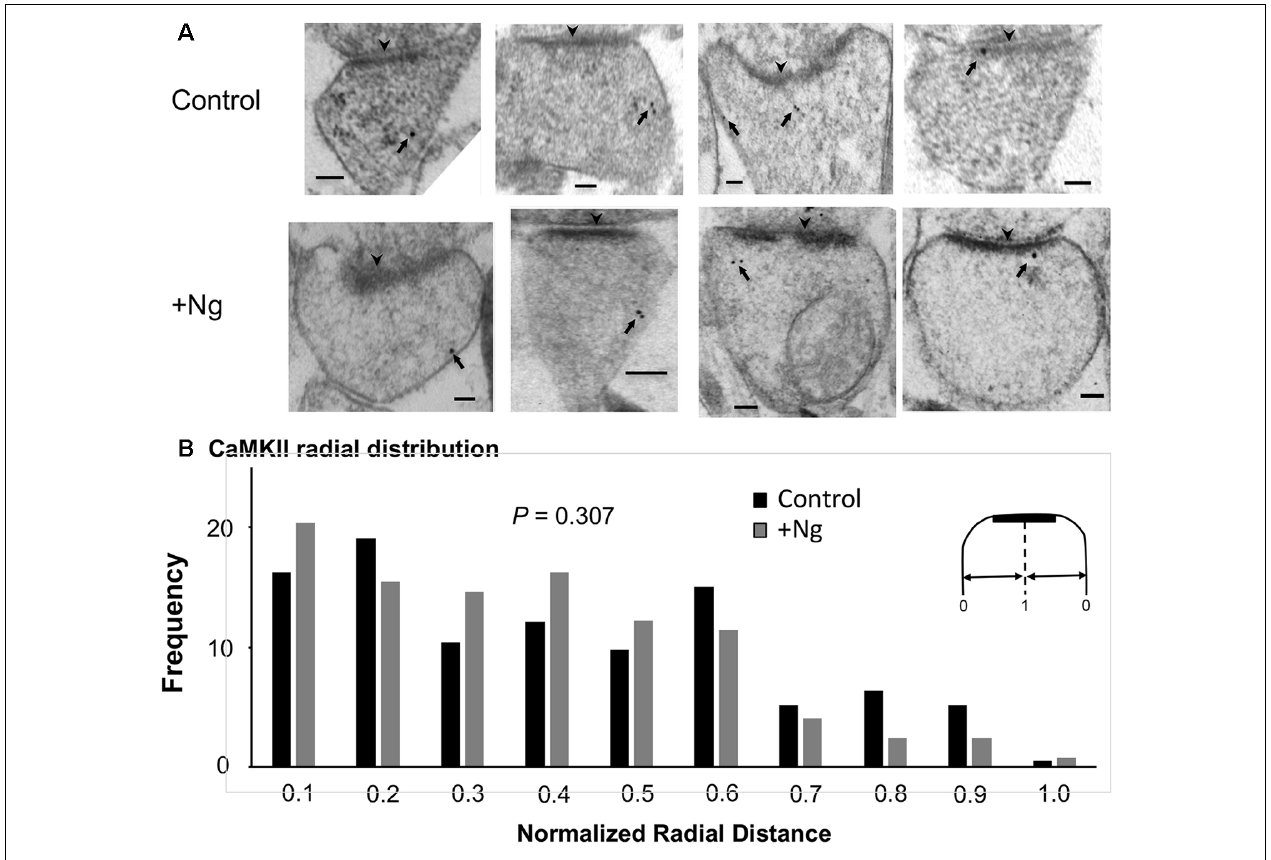
FIGURE 3 | Ng does not change the ultrastructural localization of calmodulin (CaM)-dependent protein Kinase II (CaMKII). (A) Representative micrographs of immunogold-EM for endogenous CaMKII in dendritic spines of the CA1 area for control and Ng-overexpressing neurons. The black arrowheads point to the postsynaptic density (PSD). Arrows indicate anti-CaMKII immunogold particles. Scale bar, 100 nm. (B) Frequency histogram in control ( n = 192) and Ng-overexpressing ( n = 131) neurons. The distance of each gold particle was normalized (x-axis) to the corresponding radius of the spine measured through that particle. Ng does not change CaMKII radial